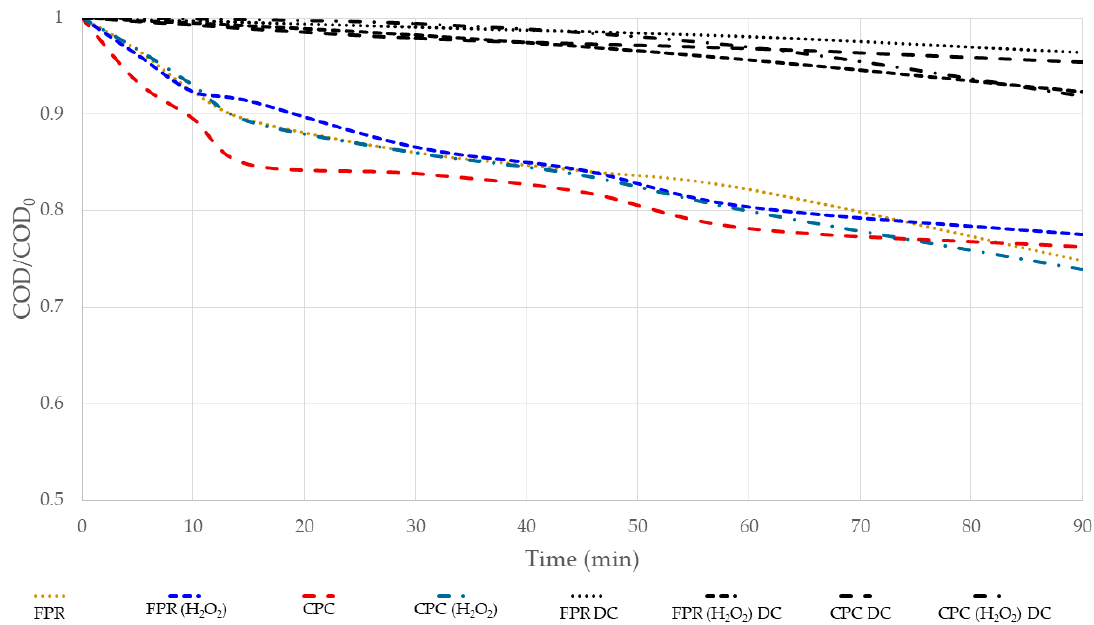
Figure 1. Chemical-oxygen-demand decrease during photolytic degradation for both flat-plate reactor (FPR), with (FPR(H 2 O 2 )) and without (FPR) H 2 O 2 addition, and compound parabolic collector reactor (CPC), with (CPC(H 2 O 2 )) and without (CPC) H 2 O 2 addition. Control experiments performed in the dark (DC) are also included for both flat-plate reactor (FPR), with (FPR (H 2 O 2 ) DC) and without (FPR DC) H 2 O 2 addition, and compound parabolic collector reactor (CPC), with (CPC(H 2 O 2 ) DC) and without (CPC DC) H 2 O 2 addition.